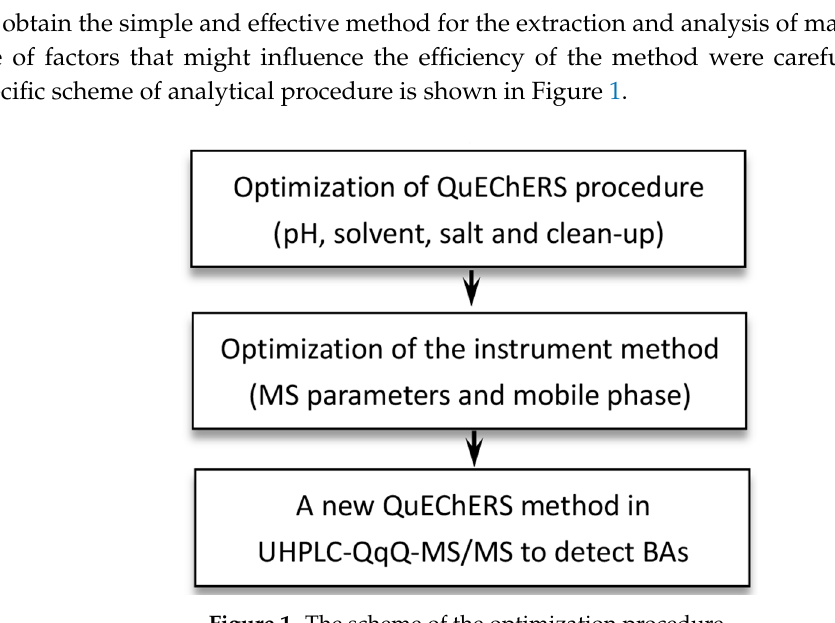
Figure 1. The scheme of the optimization procedure.